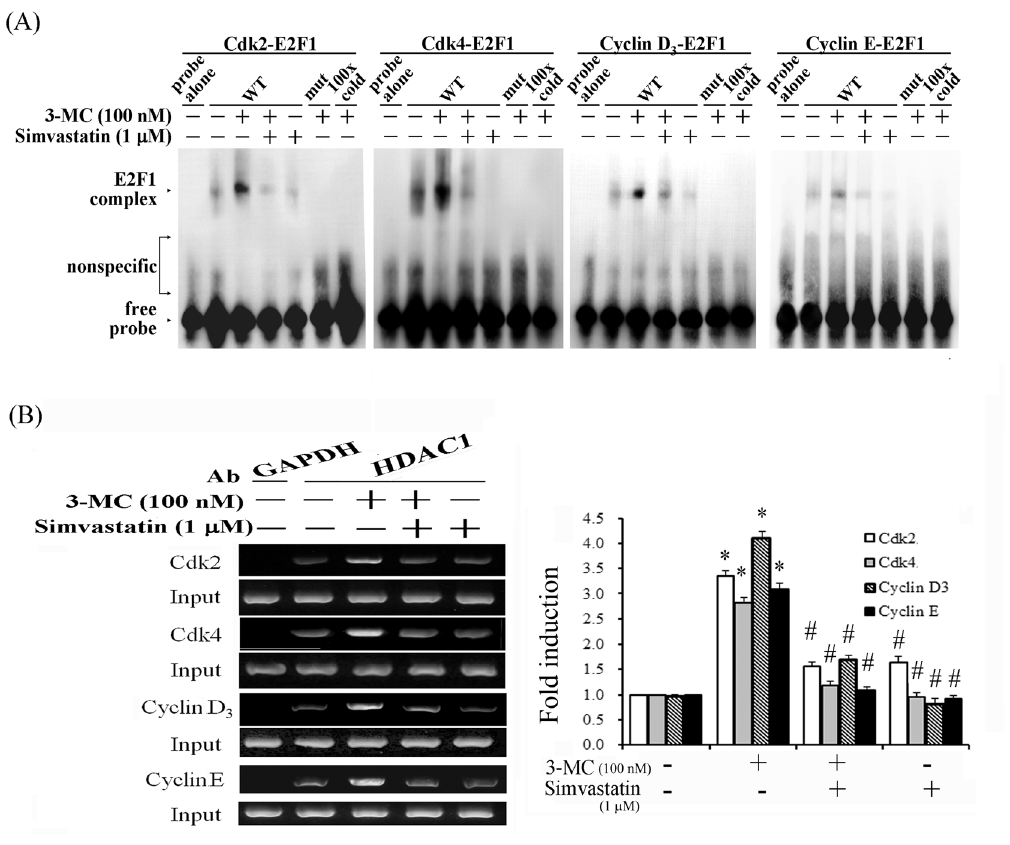
Figure 6. Elimination of 3MC-mediated increases in E2F/HDAC1 binding to the E2F responsive element in the promoters of Cdk2/4 and CyclinD3/E1 by simvastatin treatment. (A) Cells were cultured and treated with 100 nM of 3MC for 1 h after 1 h of simvastatin pretreatment. Nuclear proteins were assayed for E2F binding activity by WT and mut probes in an EMSA assay, as described in Materials and Methods. The term ‘‘100xcold’’ denotes a 100-fold molar excess of unlabeled oligonucleotides relative to the biotin-labeled probe; this was added to the binding assay to compete with the unlabeled oligonucleotides. The mobility of the E2F-E2F responsive element complex is indicated. Representative results of 3 experiments are shown. (B) A ChIP assay was performed in cells that received simvastatin pretreatment for 1 h, or followed by the 3MC challenge for 1 h, as indicated. The DNA associated with HDAC1 was immunoprecipitated with an anti-HDAC1 antibody; thereafter, PCR amplification was used to determine the extent of the association between HDAC1 and the functional E2F-binding sites in the promoters of Cdk2/4 and Cyclin D3/ E1. An anti-GAPDH antibody was used as a negative control for the ChIP assays. Representative results of 3 experiments are shown, and data are presented as the mean 6 SEM (* P , 0.05 vs. the control; # P , 0.05 vs. 3MC treatment alone).